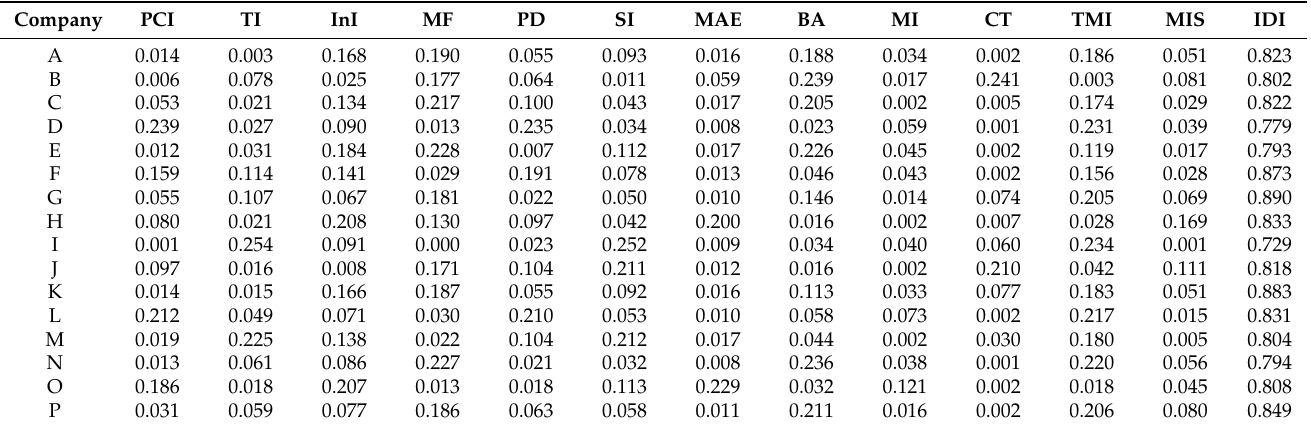
Table 5. Share distribution of indicators of the studied enterprises and their replication in the context of integrated development.